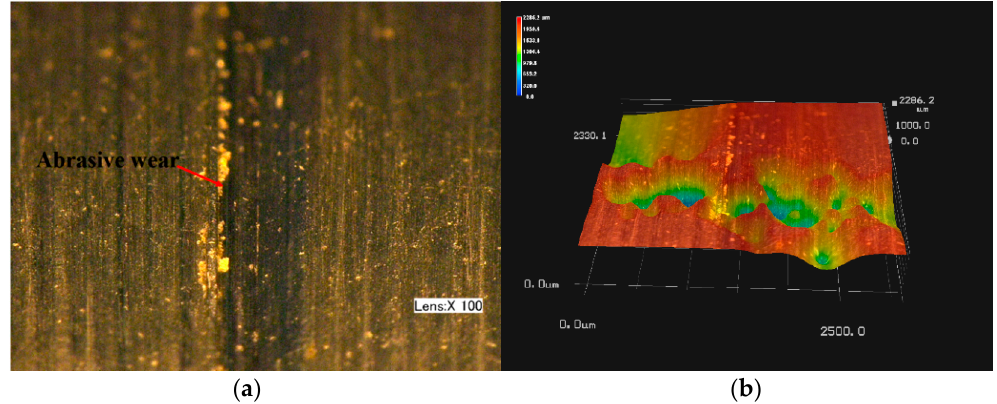
Figure 10. Micrographs of the third specimen: ( a ) 2D micrographs; ( b ) 3D micrographs.